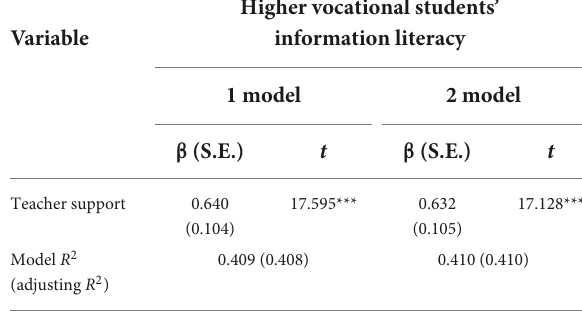
TABLE 3 Independent influence of teacher support on vocational students’ information